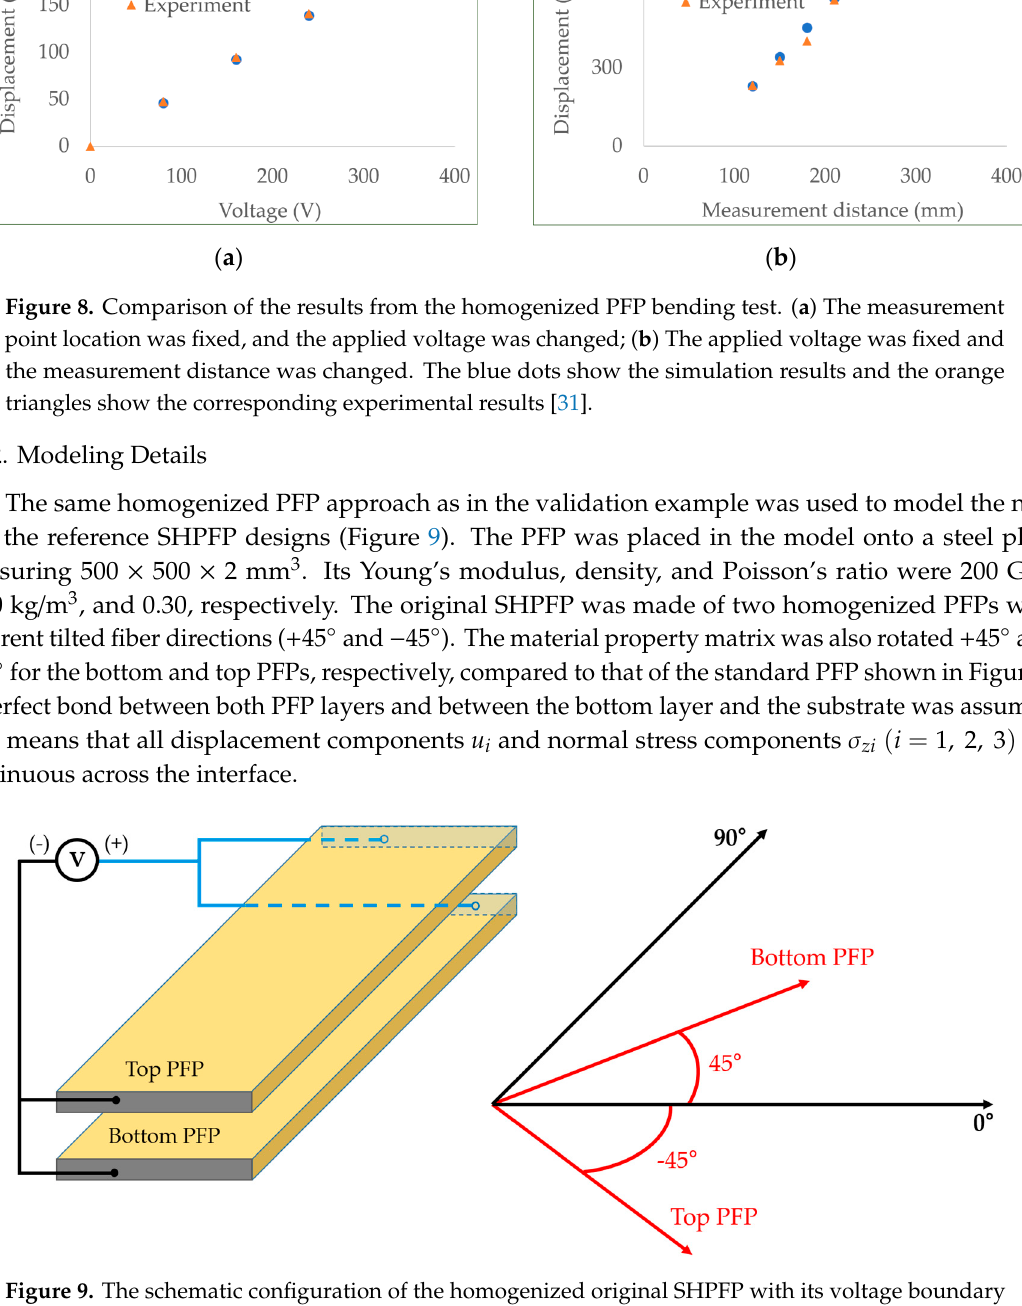
Figure 9. The schematic configuration of the homogenized original SHPFP with its voltage boundary condition. The red arrows indicate the direction of piezoelectric fibers and the rotated material property matrix of each homogenized PFP.